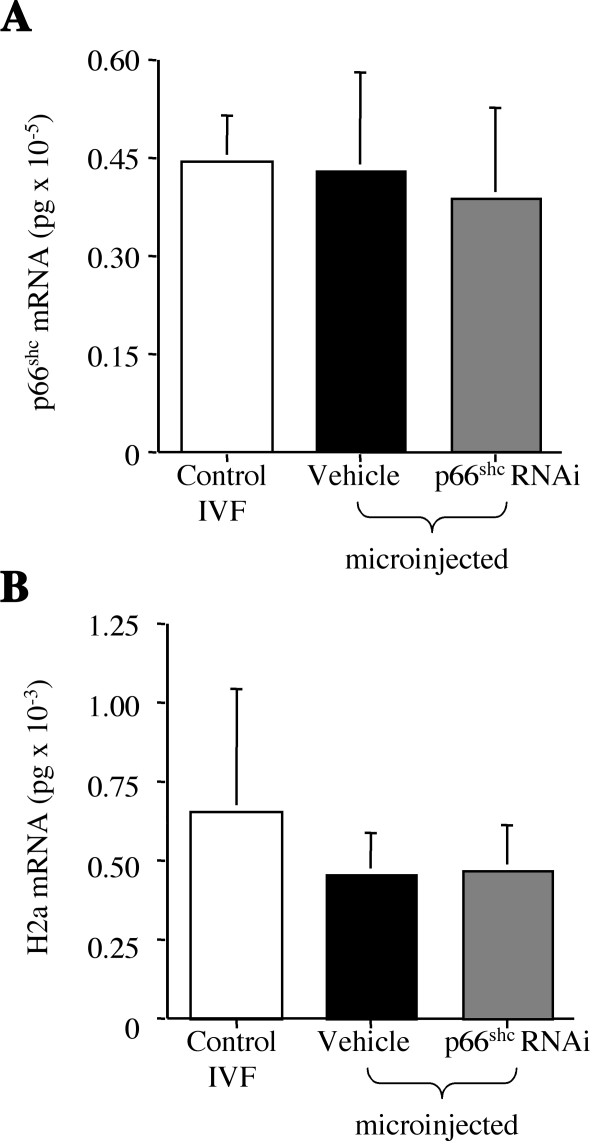
Real Time PCR quantification of p66Shc mRNA levels at the blastocyst stage following RNAi. Real Time PCR analysis of p66Shc (A) and H2a (B) mRNA levels in day 8–9 blastocysts obtained following control IVF, microinjection of the vehicle and microinjection of 12,000 p66Shc short hairpin shRNAi molecules. No significant differences (P = 0.314) in the p66Shc mRNA levels were measured (A). The quantification of the histone H2a mRNA levels was used as a control, observing no significant differences (P = 0.312) (B). The experiments were conducted on three different pools of 80–100 embryos (n = 3) and replicated three times (r = 3) for each sample. The data were normalized for the content in one blastocyst.